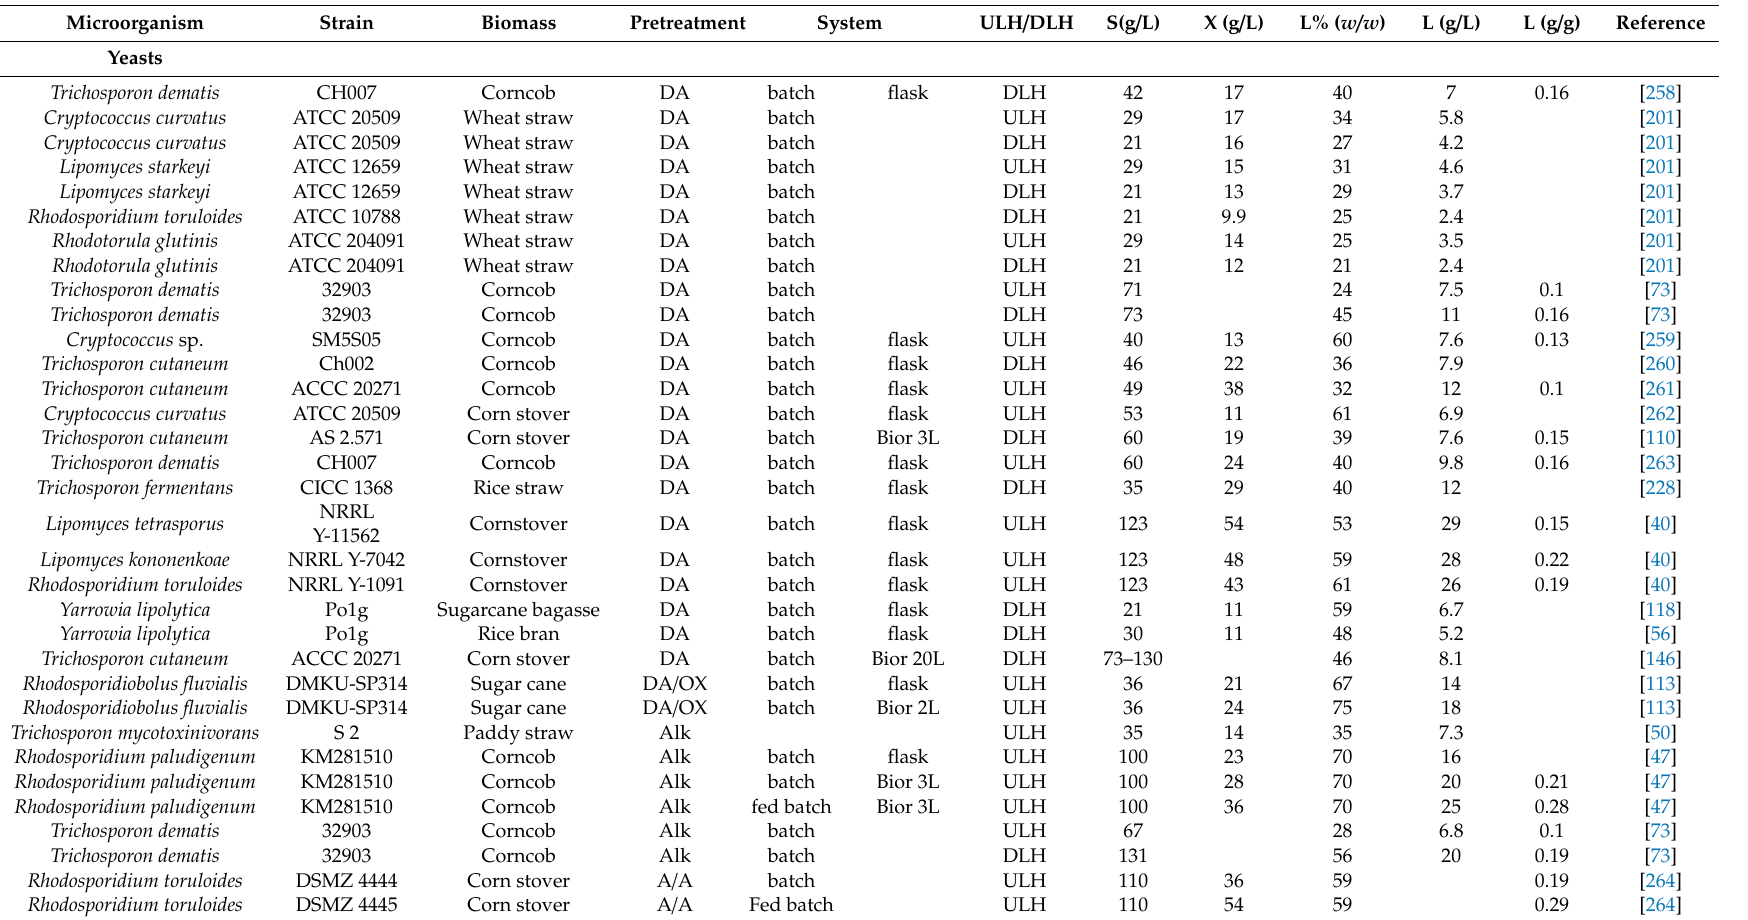
Table 4. Growth and lipid production by oleaginous microorganisms cultivated on lignocellulosic hydrolysates.